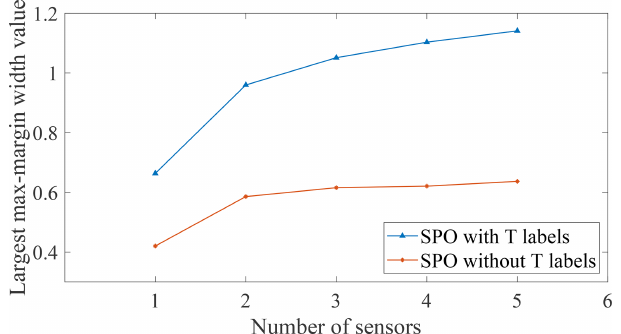
Figure 12. Optimal max-margin widths and corresponding number of selected sensors for the M1 case